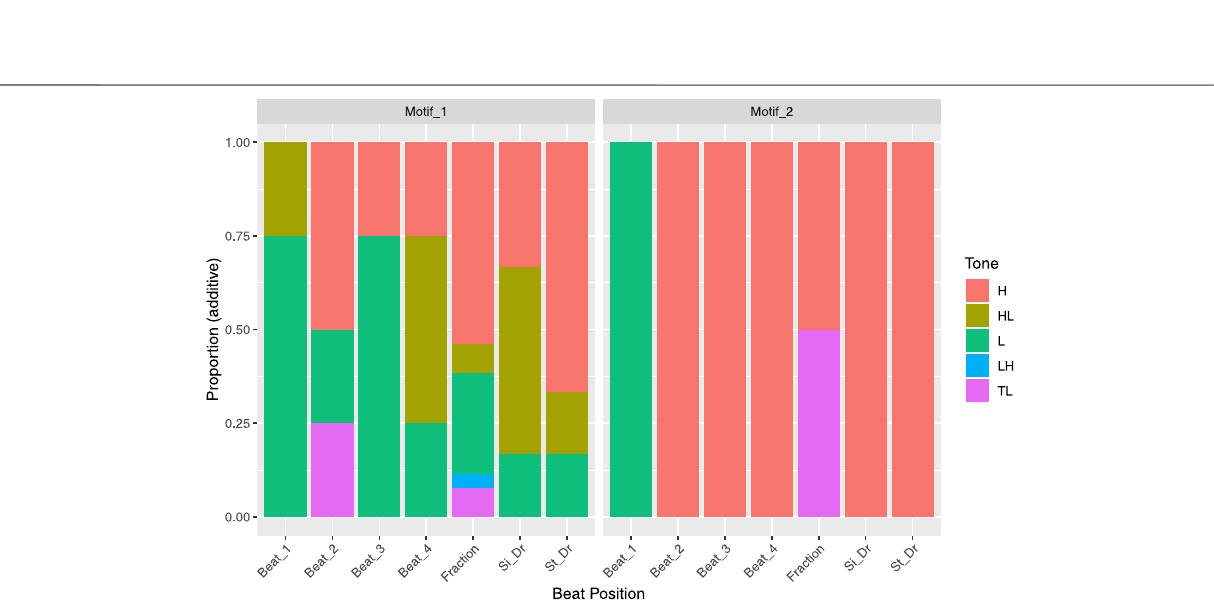
Frontiers in Communication |